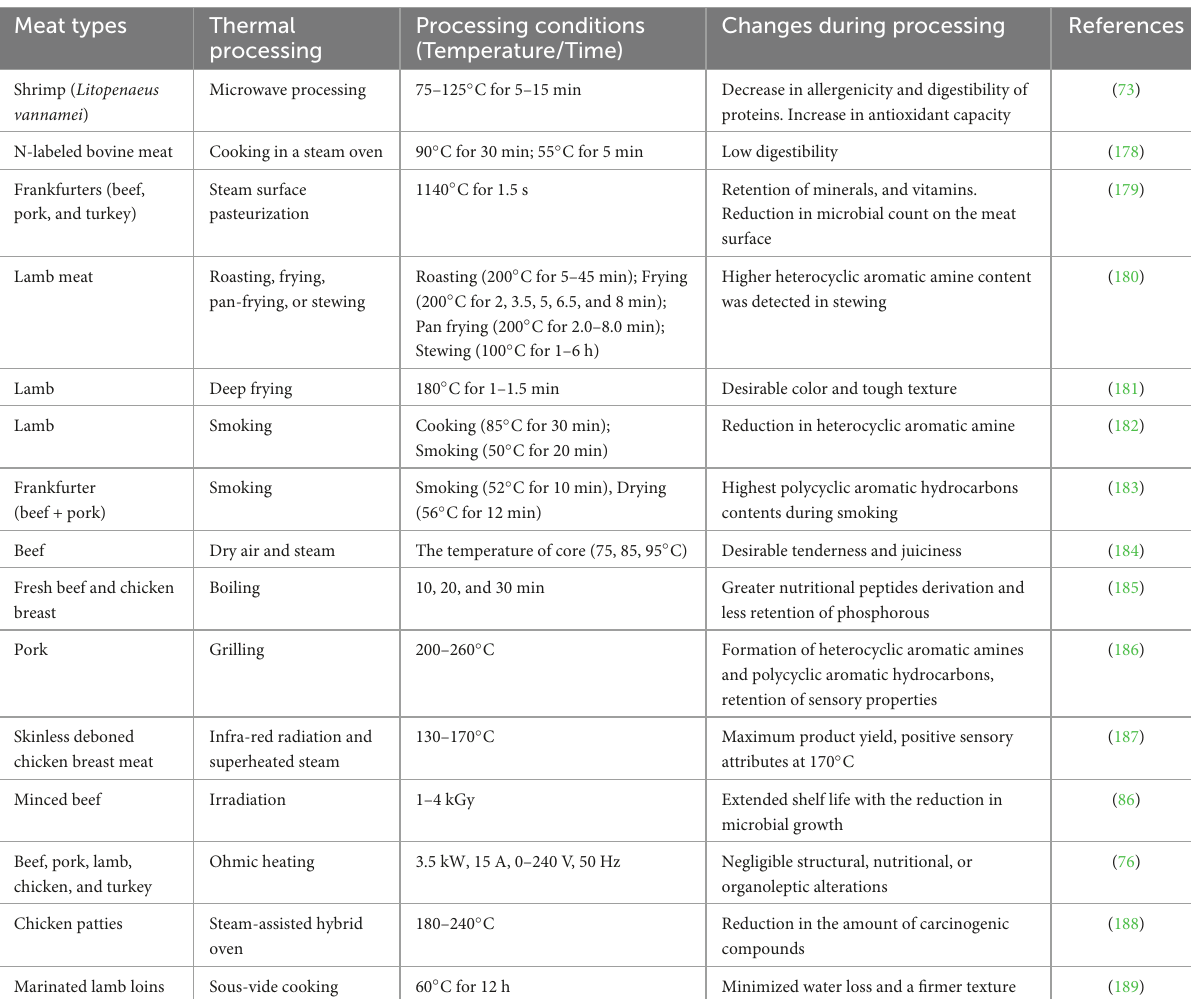
TABLE 3 Effect of various thermal processing methods on protein derived from various